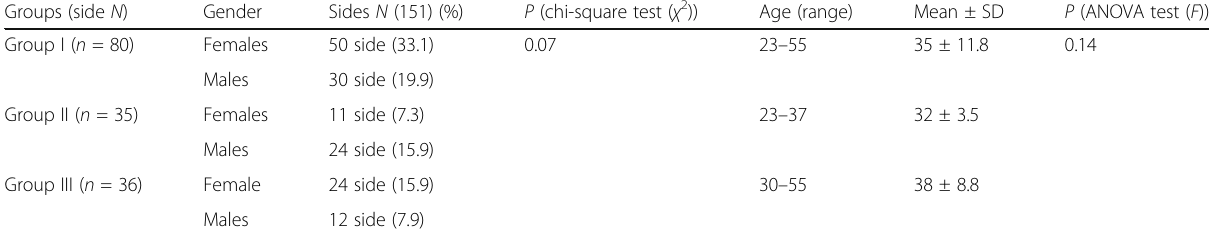
Table 1 Significant difference between the three groups regarding gender, number of SIJs examined, and age Groups (side N )